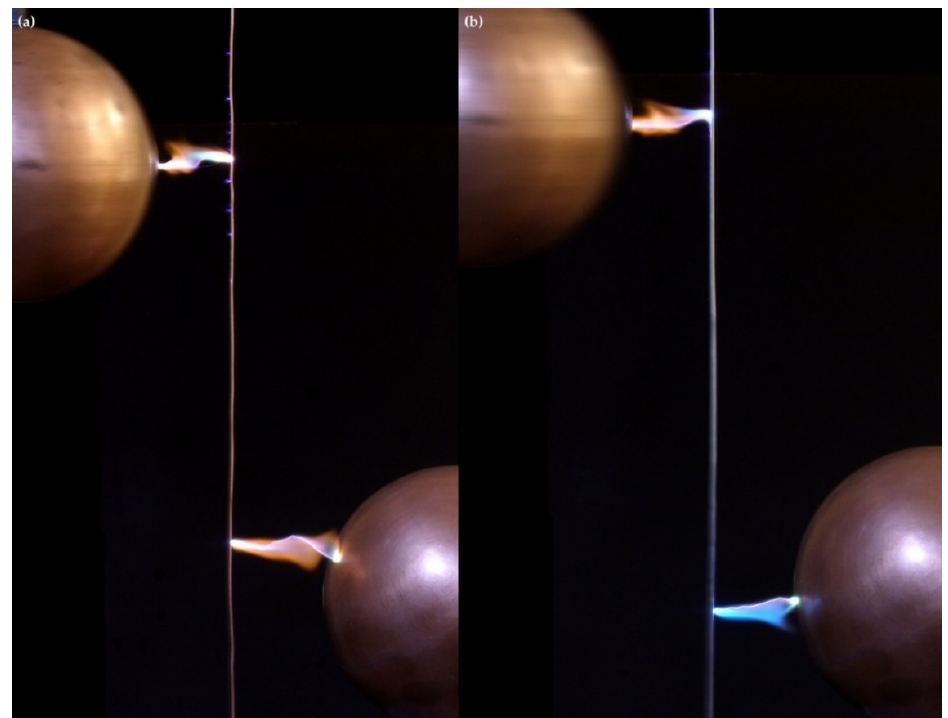
Figure 14. Bidirectional discharges over two model antenna wires: ( a ) copper and ( b ) aluminum (image ( b ) is more enlarged than ( a ); both have an 8 s exposure). The tortuosity of the upper and lower discharges could be affected by the magnetic field generated by the current flowing through the wire during the discharge.